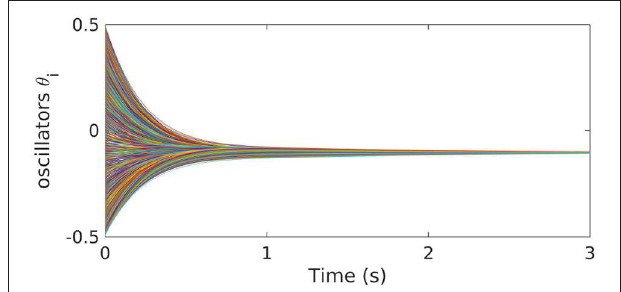
FIGURE 14 | Evolution of the controlled dynamics of the Kuramoto model (5) with N 1,000 oscillators. The control has been computed with the GD-RBM = algorithm.